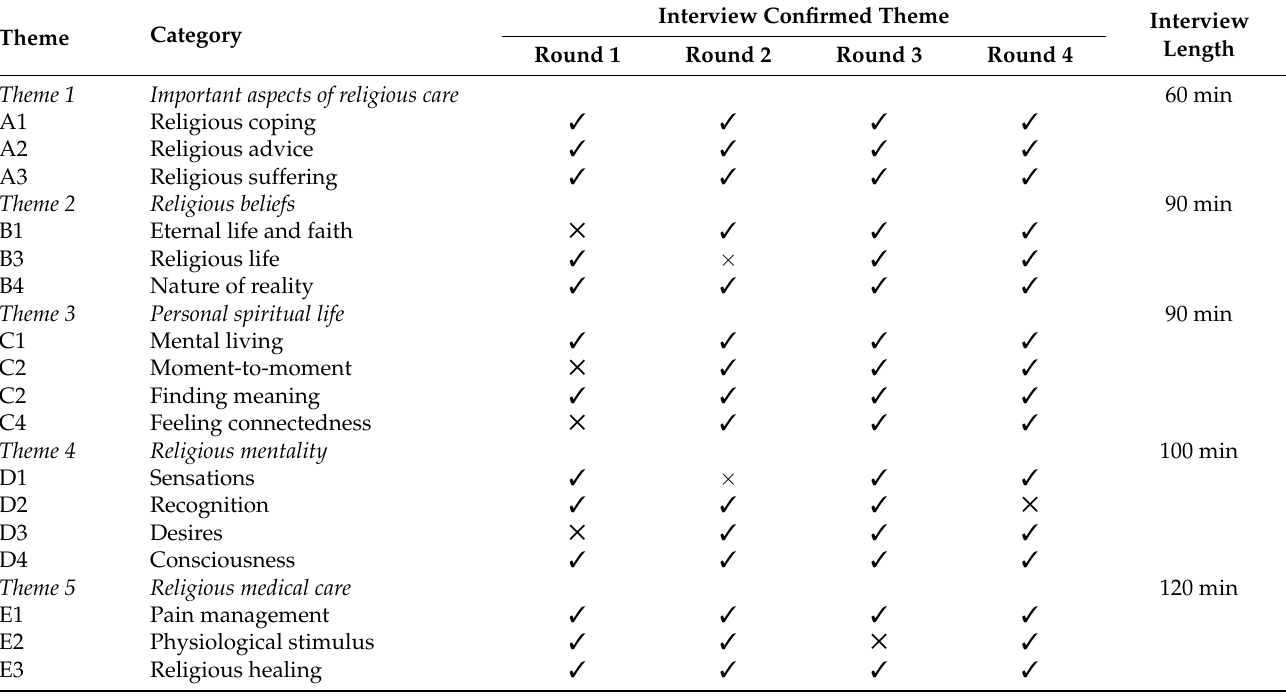
Table 3. The core theme and